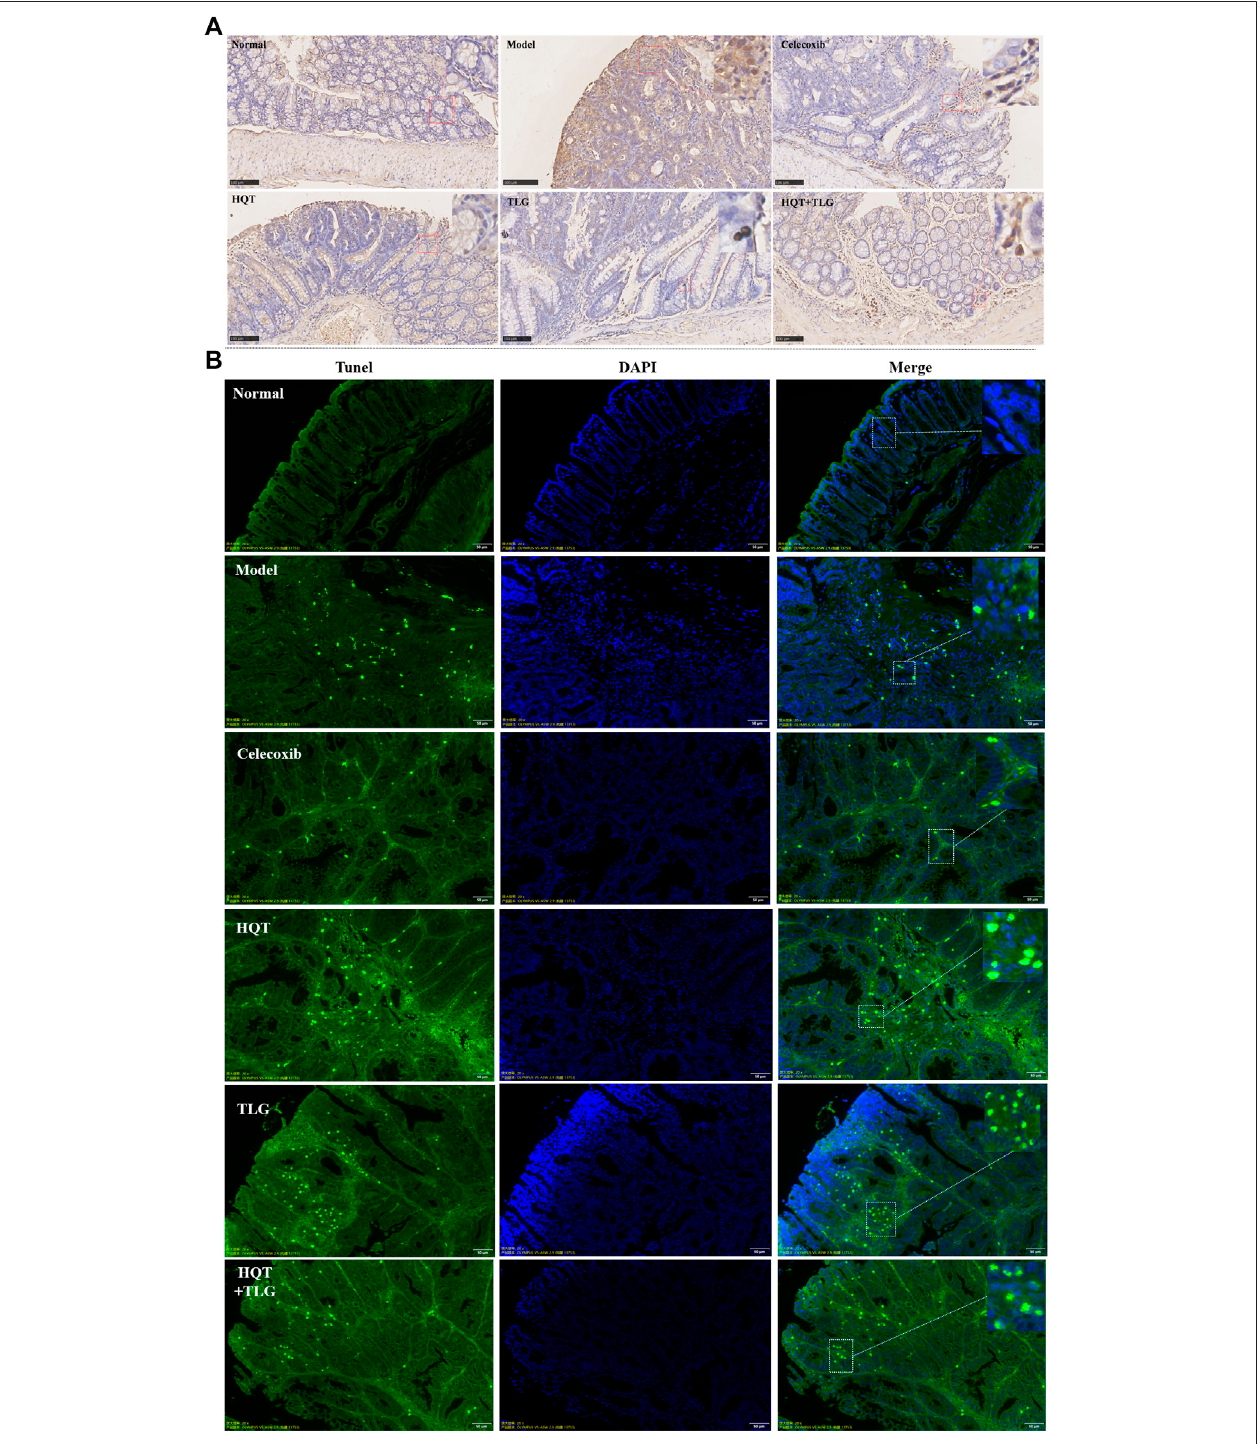
FIGURE 2 | Effect of HQT + TLG on colorectal cancer cells ’ proliferation and apoptosis. (A) Expression of Ki-67 in colorectal tumor tissues of mice in each group (DAB staining). (B) Apoptosis of tumor cells in colorectal tumor tissue of mice in each group.